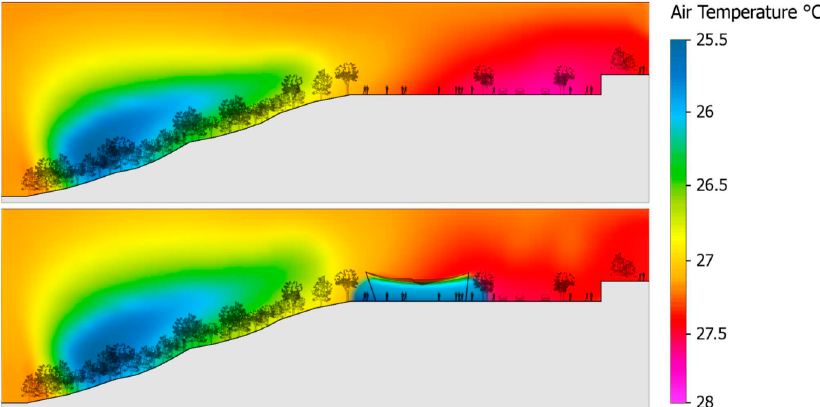
Energies 2017 , 10 , 351 Figure 8. Bus station—Device mitigation during the representative day. Figure 8. Bus station—Device mitigation during the representative day.